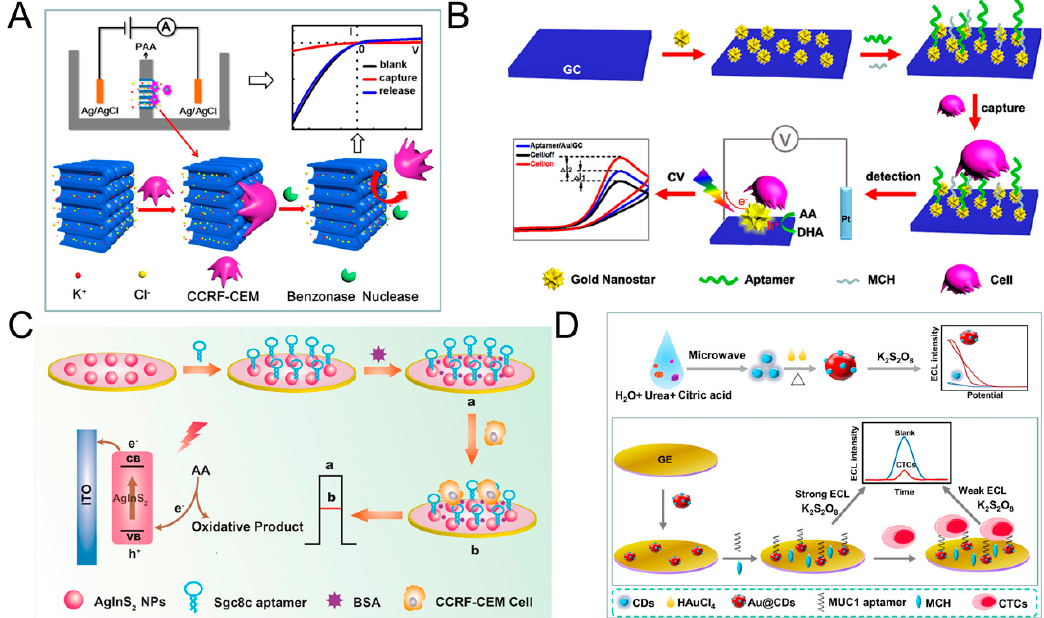
Figure 3. Direct electrochemical detection of CTC. ( A ) Linear sweep voltammetry (LSV) cytosensor for CCRF-CEM cell detection, using hybrid nanochannels and ion channels. Reprinted with